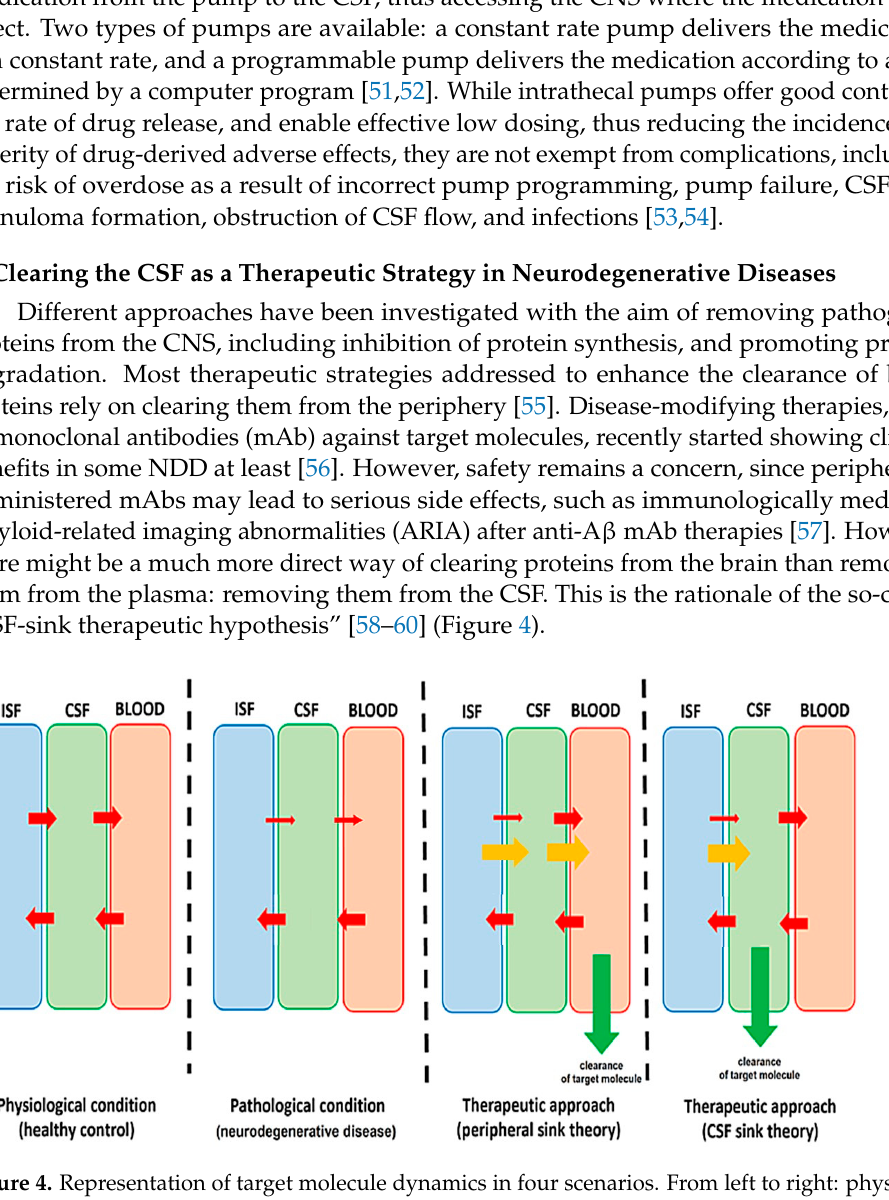
Figure 4. Representation of target molecule dynamics in four scenarios. From left to right: physiological condition (healthy subject), pathological condition (untreated neurodegenerative disease), and pathological condition treated with peripheral sink therapeutic approach or pathological treated with CSF-sink therapeutic approach. Red arrows represent spontaneous equilibrium of target molecules between CNS fluid compartments, green arrows represent pathways of therapeutic clearance of target molecules and orange arrows represent the secondary equilibrium of target molecules between CNS fluid compartments after therapy. Modified from Schreiner et al [60]. Indeed, several attempts have been made to treat neurodegenerative diseases using different CSF filtration systems. In ALS, extracorporeal CSF filtration was shown to suc- cessfully mitigate the neurotoxic capacity of CSF from subjects with sporadic Amyo- trophic Lateral Sclerosis (ALS) in vitro [61] and in a mouse model [62]. However, a very small randomized, controlled, and open study in the nineties, concluded that filtration of 200–250 mL CSF daily, over five days, did not seem to have a substantial therapeutic effect in patients with ALS [63]. In a single case of familial ALS, there was subjective, but no objective, improvement of the patient immediately after CSF filtration and two weeks later [64]. It is worth revising methods aimed at CSF dilution or enhancing CSF flow, as they are closely related to CSF-sink therapeutic strategy. In AD, mechanical dilution of CSF has long been a proposed therapeutic approach [65]. CSF shunts such as ventriculo-peritoneal, ventriculo-pericardial, ventriculo-atrial and lumbo-peritoneal shunts are the recom- mended therapy for communicating hydrocephalus. Noteworthy, shunting procedures delay intracerebral deposition of A β in patients with communicating hydrocephalus [66]. COGNIShunt is a system for a continuous, low-flow ventriculoperitoneal shunt (Eunoe, acquired by Integra Lifesciences). Results of the clinical trial showed that the difference between treatment groups, while still favoring the COGNIShunt group, was not statisti- cally significant [67]. Arethusta (Leucadia Therapeutics) is a system based on an implant- able device to restore CSF flow across the cribriform plate, with no clinical reports yet. 4. Intrathecal Pseudodelivery of Drugs: Concept, Advantages, and Disadvantages Therapeutics such as enzymes, antibodies, and even transport proteins (e.g., albu- min), which are mostly intended to link with molecular targets to be removed from the organism, do not really need to be released in the fluid or tissue to action. In fact, binding to the molecular target can be achieved regardless of the compartment. With this in mind, IT pseudodelivery of drugs is a novel concept to administer drugs to treat CNS conditions relying on the CSF-sink therapeutic strategy [60], by means of implantable DDS to put in touch therapeutics with molecular targets inside of the device, without delivering to the